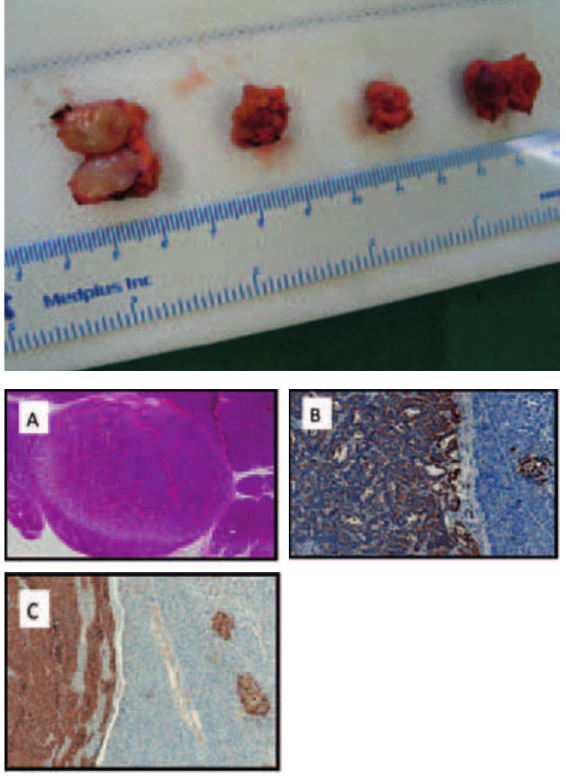
Figure 4. Well-differentiated pancreatic neuroendocrine tumor (somatostatinoma, gastrinoma). A. HE 20x. The tumor nodule (0.3 cm); B. IH 100x. Diffuse glucagon expression in the tumor (left) and Langerhan’s island (right); C. IH 100x. Diffuse somatostatin positivity in the tumor (left) and Langerhan’s islands (right). HE - Hematoxylin and eosin staining; IH - Immunohistochemical staining.